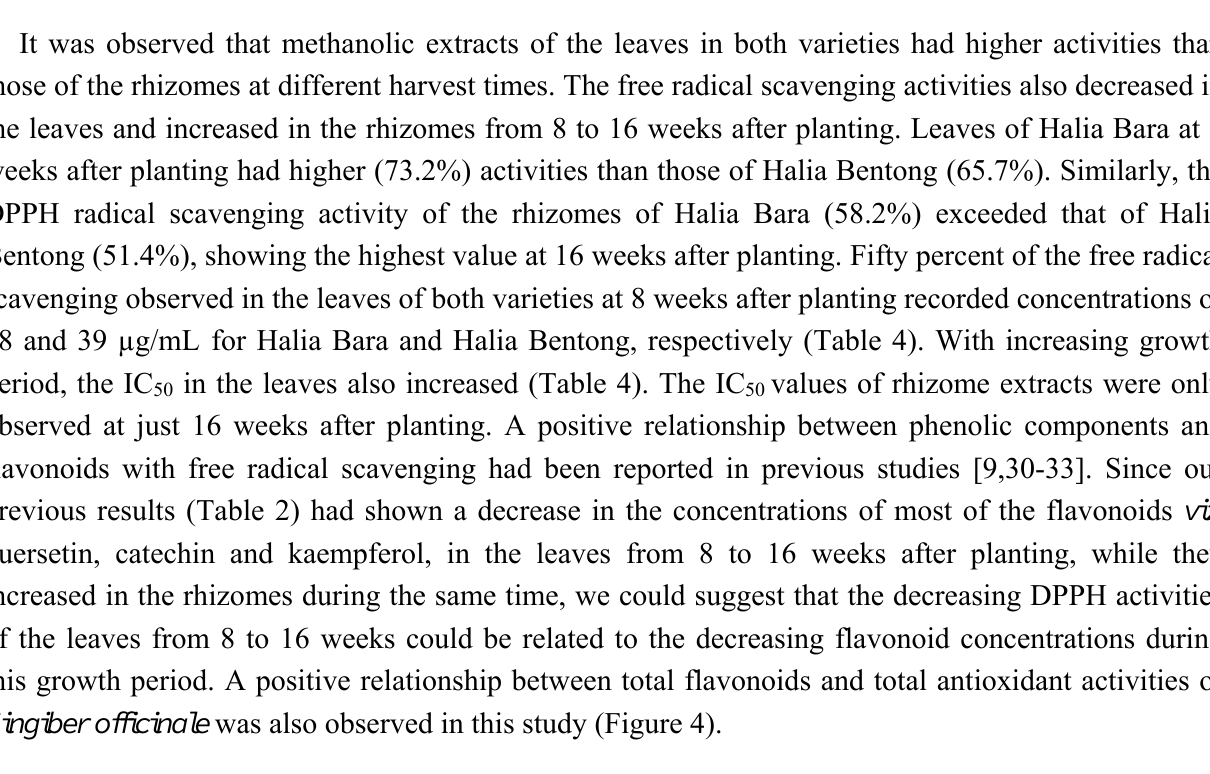
Weeks after planting